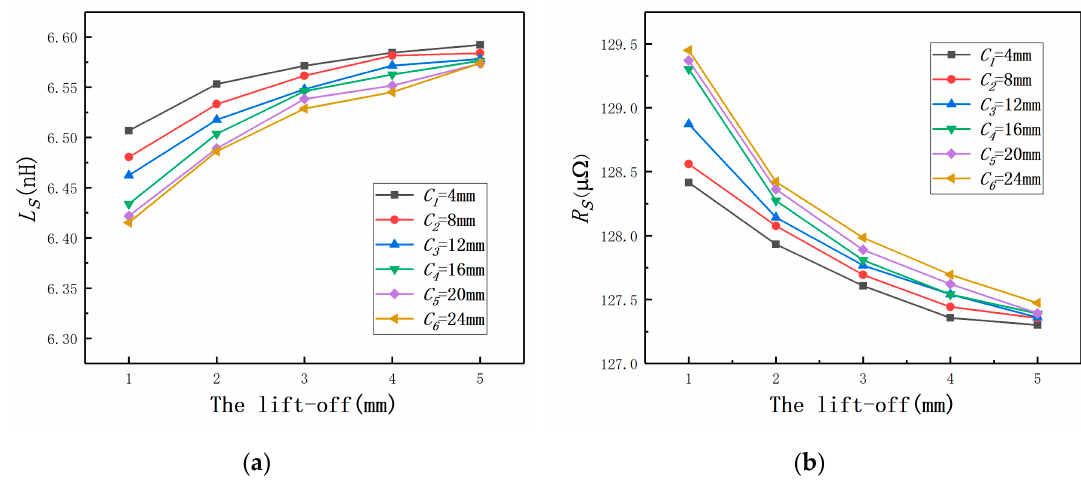
Figure 11. The change laws of the coil equivalent impedance under different radii: ( a ) the coil equivalent inductance; ( b ) the coil equivalent resistance.